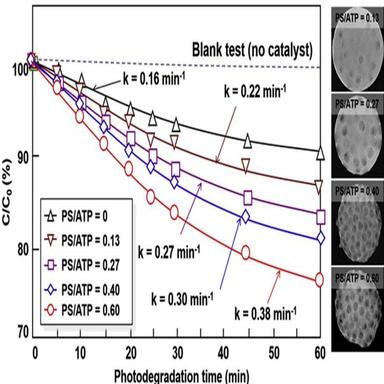
Photodegradation of RhB by WO3 particles with various PS/ATP mass ratios. Empirically determined rate constants (k) for each particle type are also given. Reprinted (adapted) with permission from (Chemical Engineering Science 2013; 101; 523–532). Copyright © 2013, Elsevier (.